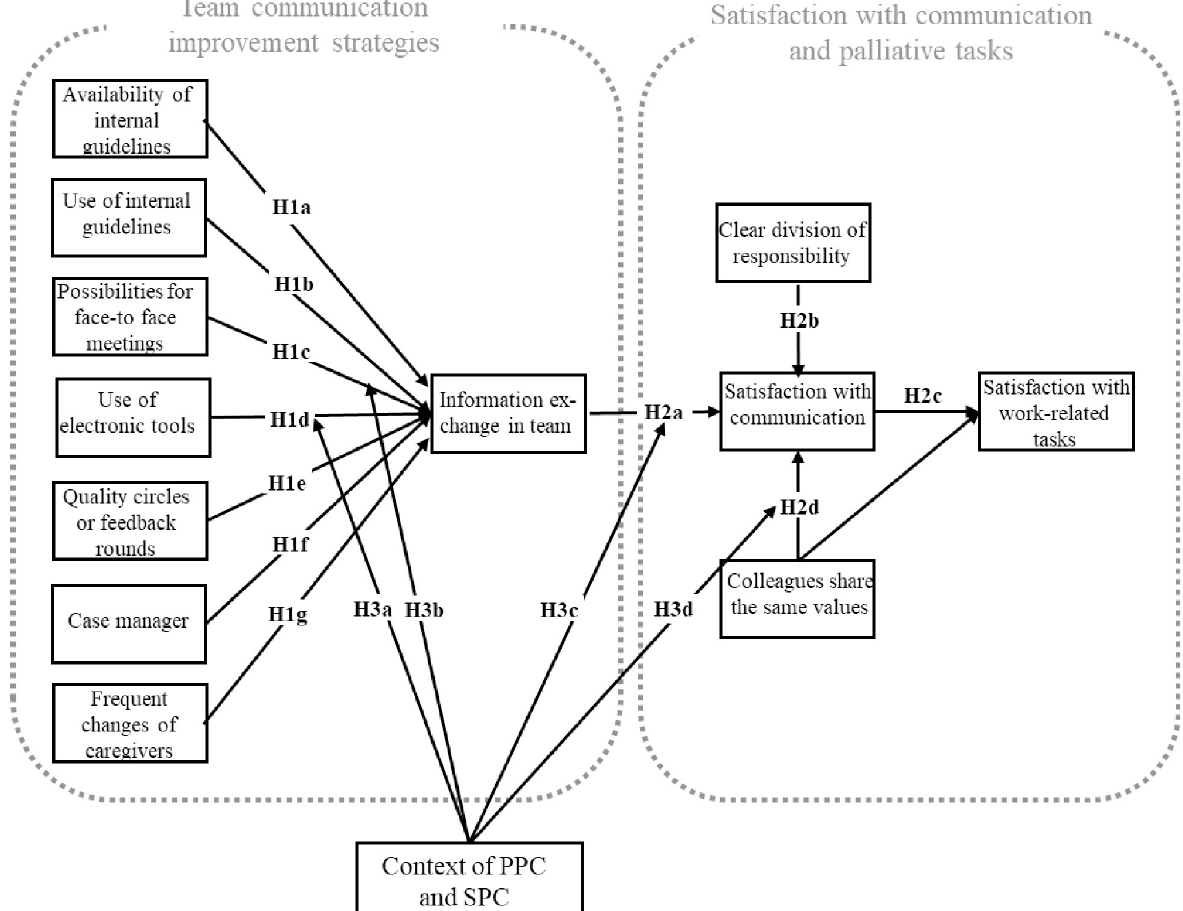
Fig 1. Theoretical model. Hypothesized predictors of information exchange in the team and hypothesized additive and interactive effects of information exchange in the team on satisfaction with communication and satisfaction with work-related tasks (after Bainbridge et al., 2010).